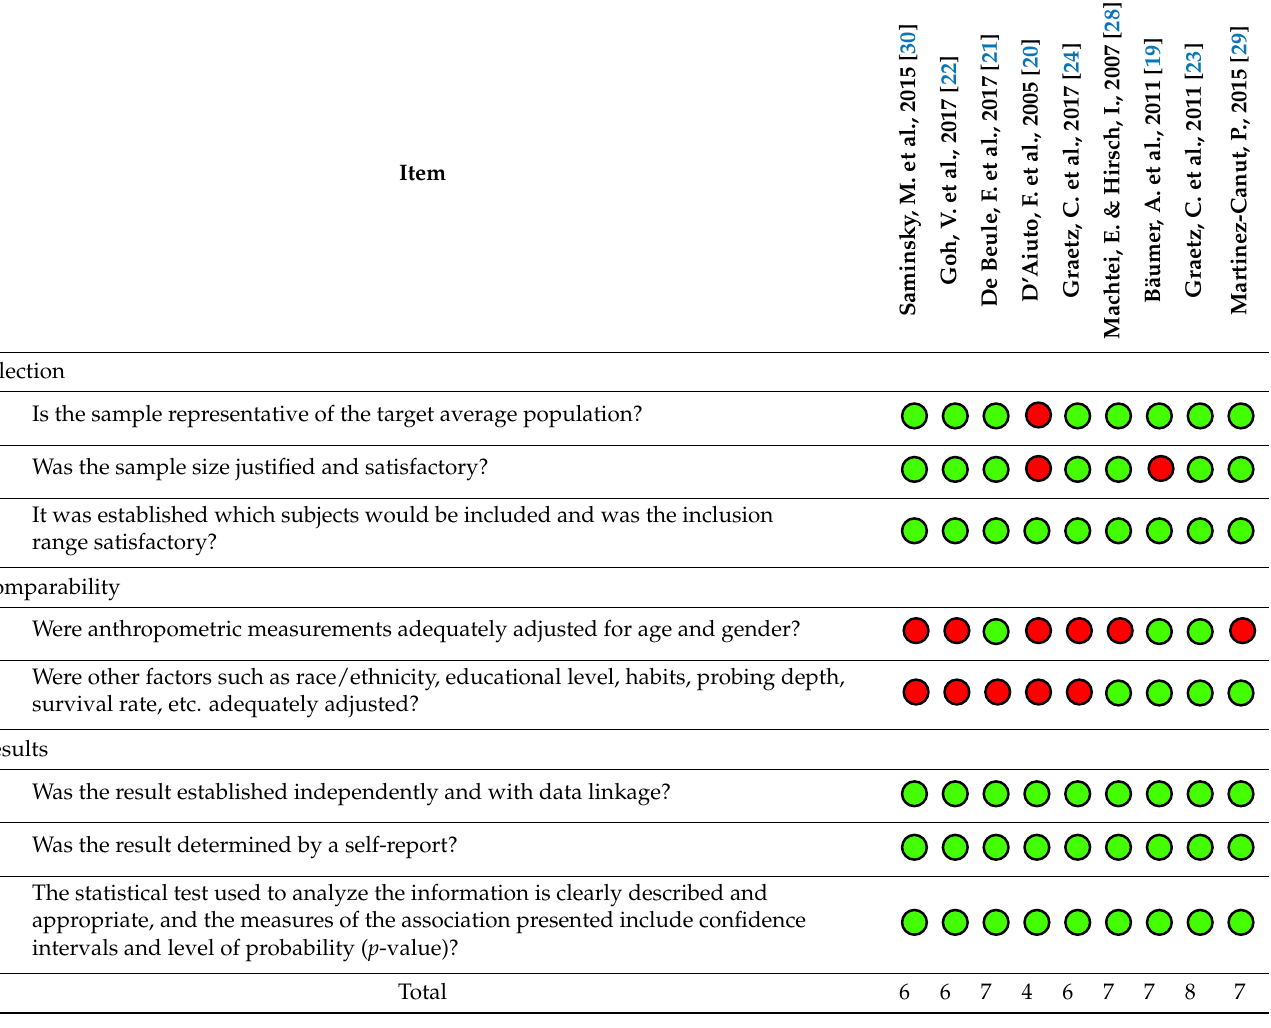
Table 4. The table shows the risk of bias criteria using the adapted Newcastle Ottawa Scale (NOS) for cross-sectional studies. If the criterion is met, a green dot is placed in the box, otherwise, if it is not met, a red dot is placed. Studies with a total score of 7 or 8 green points were considered a low risk of bias; 6 green dots were considered to be at medium risk of bias; 5 green dots or less were judged to be at high risk of bias.